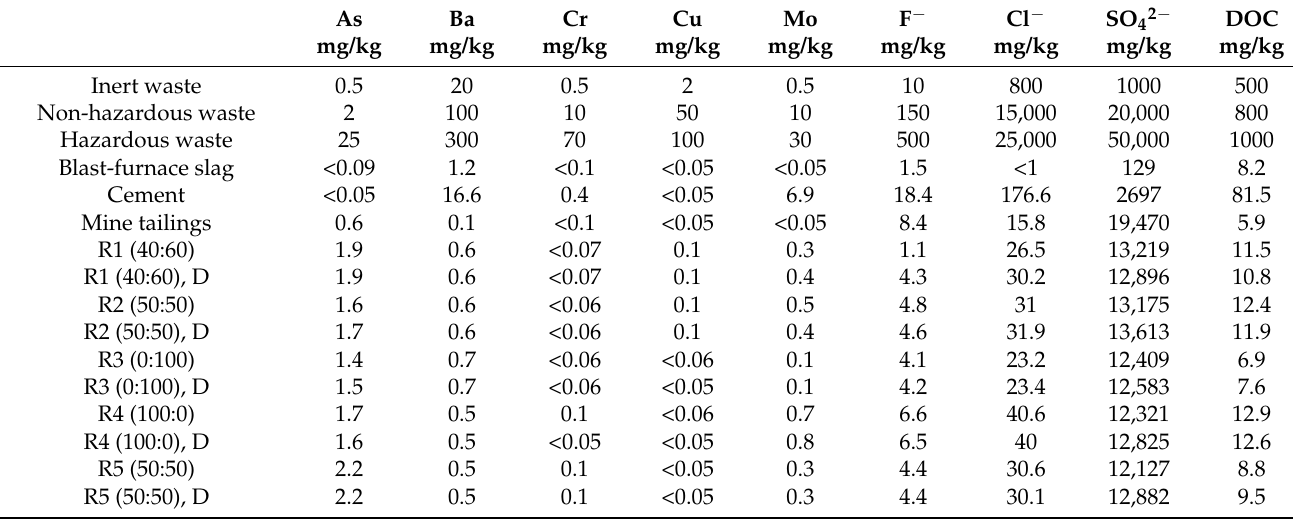
Table 5. Two-step batch leaching test results comparing the parent material and CPB-recipes leachates against current threshold values as stipulated by the Finnish government degree on landfills [32]. Sb, Cd, Pb, Ni, Se, Zn results are below detection limit. Explanation for R1–R5, see Table 1. D denotes duplicate